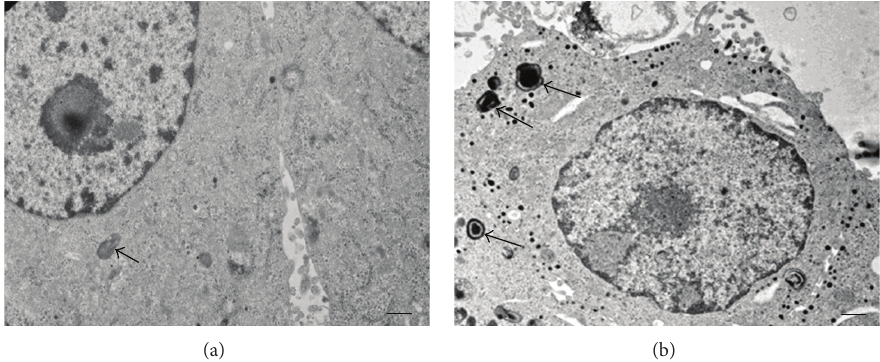
Figure 5: Ultrastructural analysis of lithium-treated PC12 cells. Membrane-delimited vacuoles in the cytoplasm with the characteristic features of autophagic vacuoles (arrows) are present in untreated cells (a) and more numerous in lithium-treated sample (b). Scale bars = (a): 1 𝜇 m; (b): 0.4 𝜇 m.